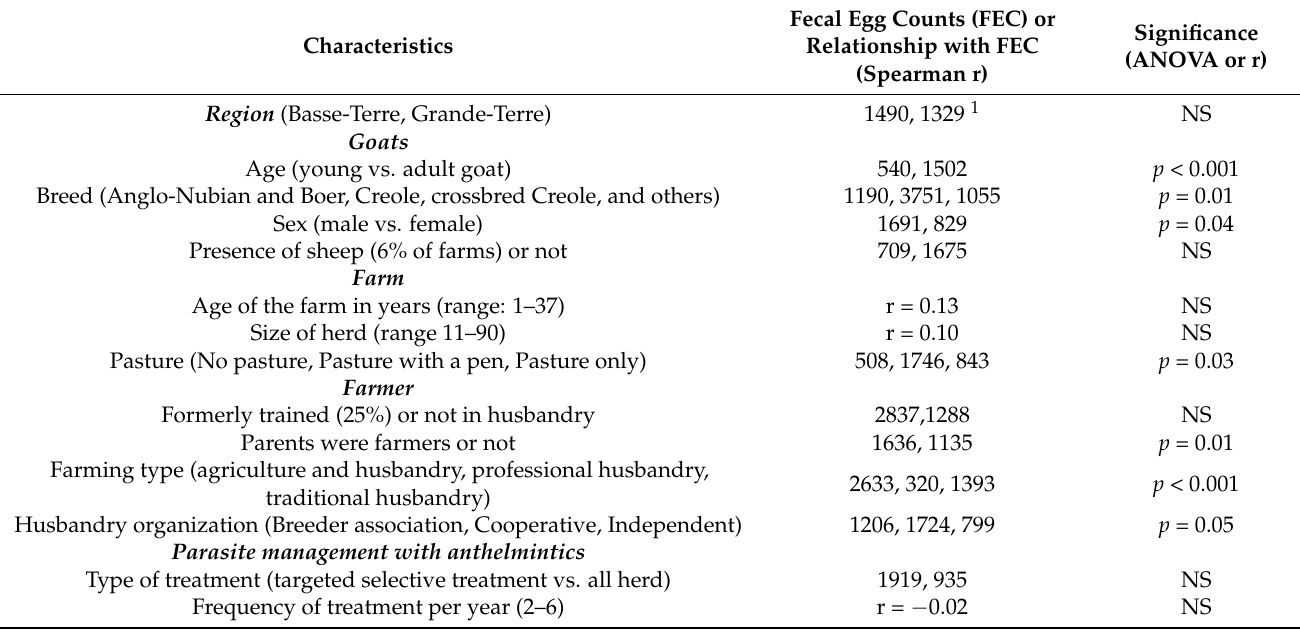
Table 1. Characteristics of the farms and their relationship with fecal egg counts of gastrointestinal nematodes. Fecal egg counts are related to the qualitative data (ANOVA) or quantitative data (Spearman r).